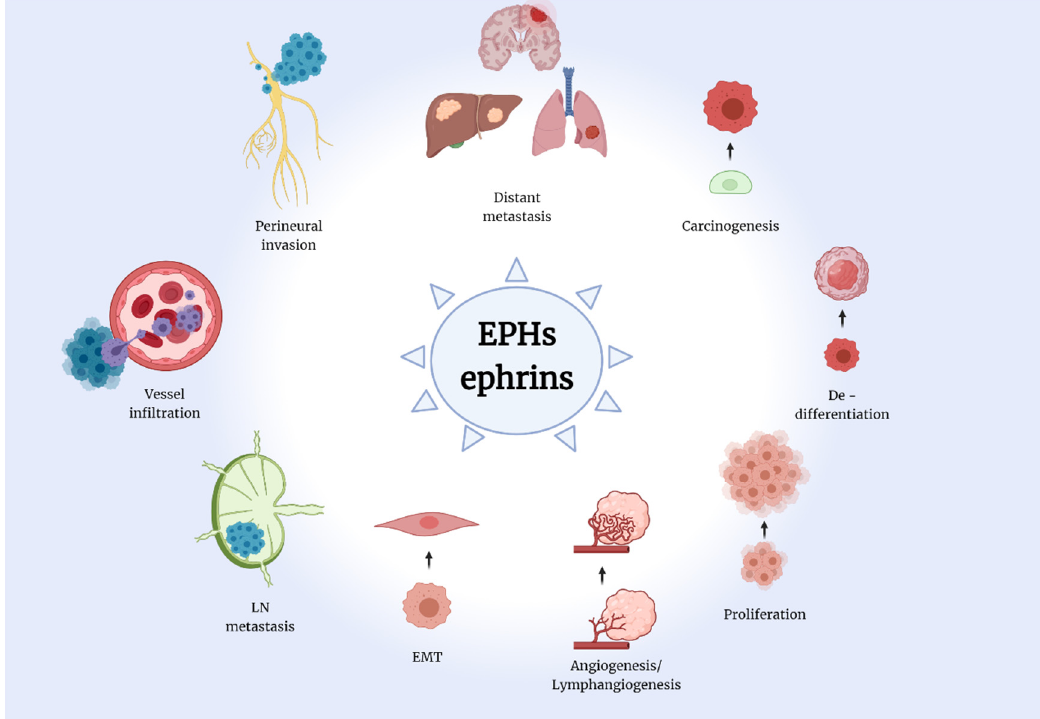
Figure 2. The Eph/ephrin system is implied in a multitude of tumorigenic processes. EPH: erythropoietin-producing human hepatocellular receptors, ephrins: EPH family receptor interacting proteins, EMT: epithelial-mesenchymal transition, LN: lymph nodes. Created with BioRender.com (accessed on 2 August